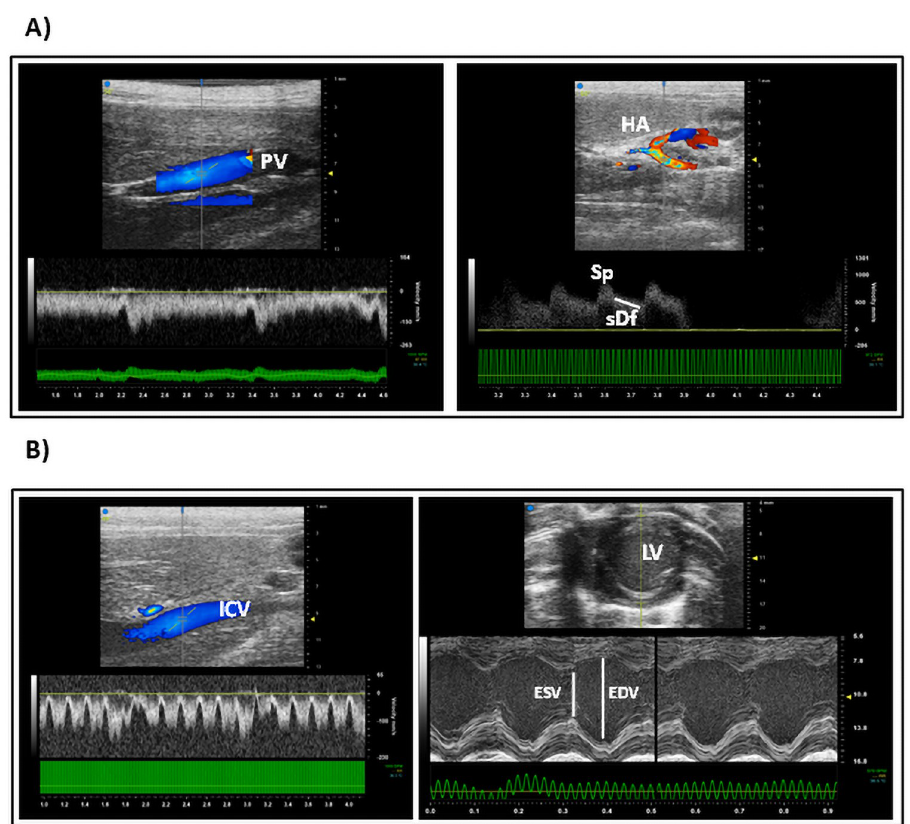
Fig 2. High-Frequency Ultrasound (HFU) examination for hepatic and cardiovascular hemodynamic assessment. A) Abdominal HFU study for hepatic perfusion analysis. Longitudinal Colour and Spectral Doppler sections of Portal Vein (PV) and Hepatic Artery (HA) are presented. Systolic peak (Sp) and slow Diastolic fall (sDf) have been indicated. B) HFU study for cardiovascular hemodynamic assessment. Colour and Spectral Doppler transversal sections of Inferior Cava Vein (ICV). B-Mode and M-mode images of transverse section of Left Ventricle (LV). Motility, End Systolic and End Diastolic Volumes (ESV and EDV respectively) were evaluated in M-mode. PV: porta vein, HA: hepatic